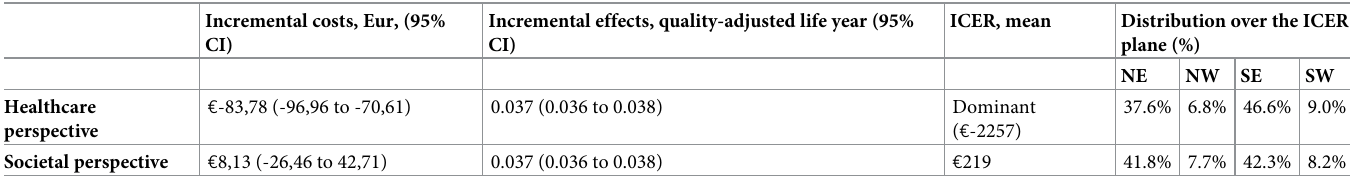
Table 3. Results of cost-effectiveness analyses.